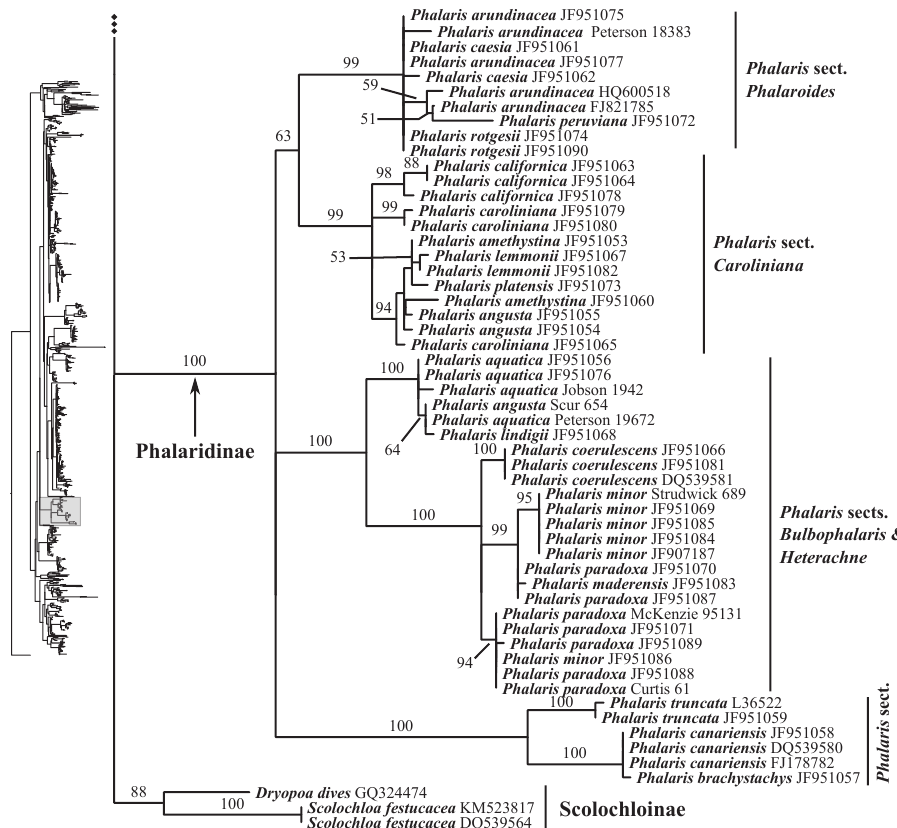
Figure 17. A portion (Phalaridinae and Scolochloinae) of the maximum likelihood phylogram inferred from ITS data. ML bootstrap support is recorded along branches when >50%. The shaded area of the smaller tree on the left indicates the location in the overall tree of the portion shown. The subdivisional classification of Phalaris follows Voshell et al. (2016). The backbone branch represented by ellipses is shown only in Fig.